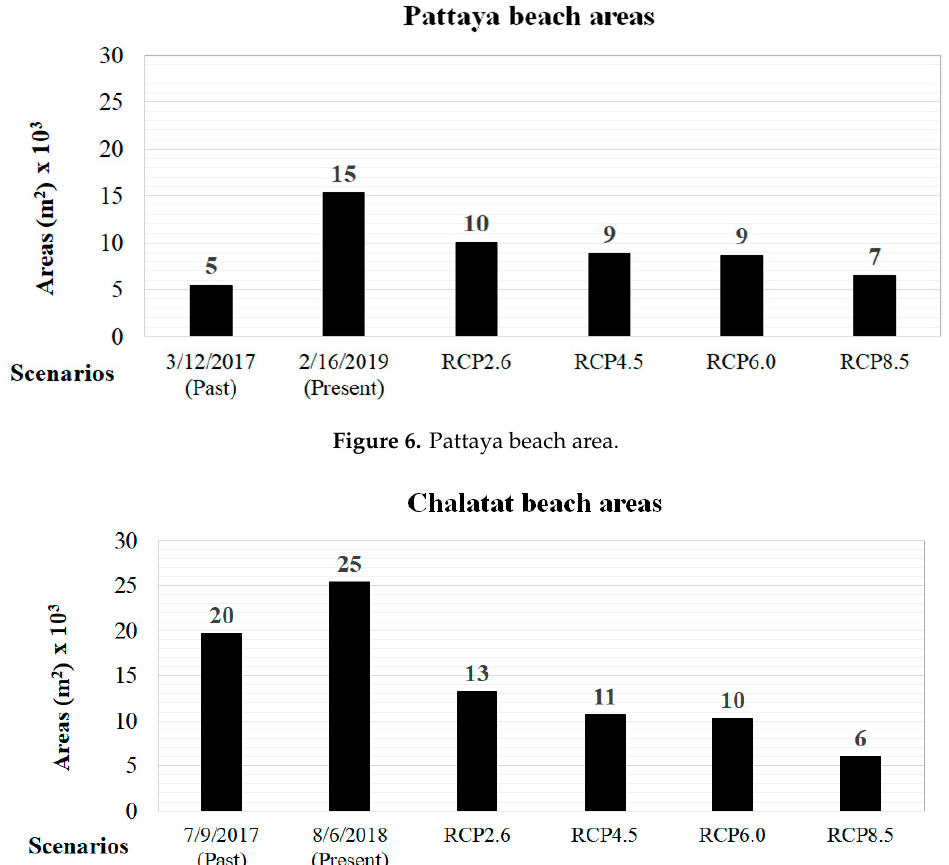
Figure 7. Chalatat beach area.